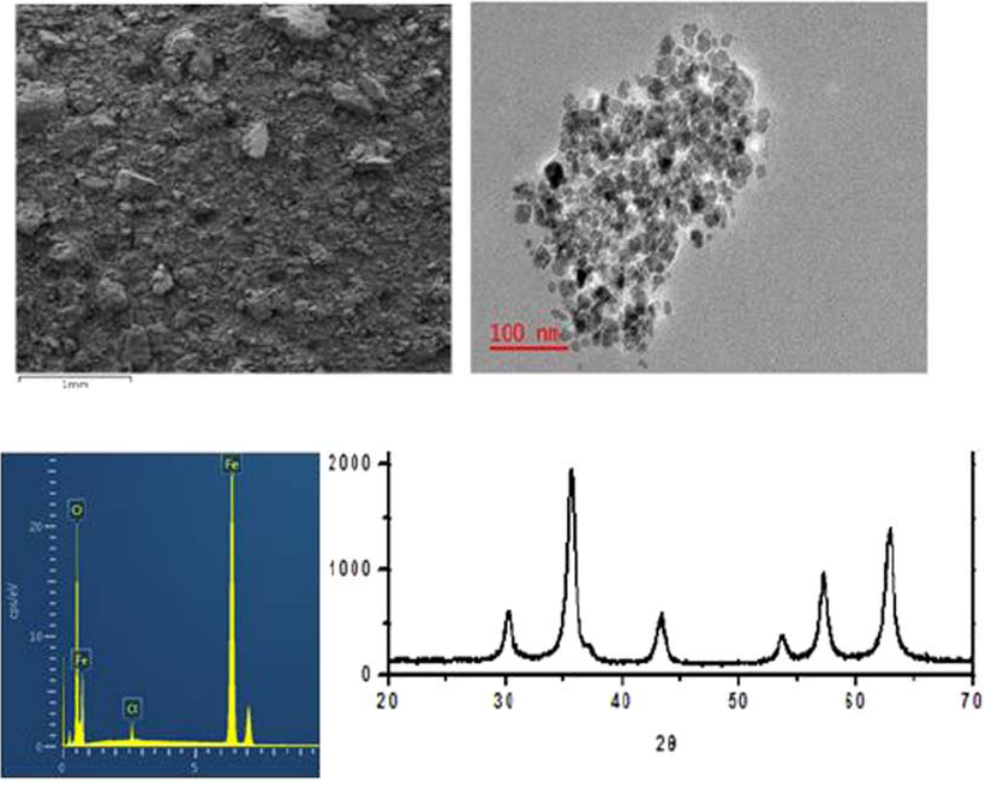
Figure 3: SEM ( left ) , TEM ( right ) , EDS ( bottom ) and XRD pattern of Fe 3 O 4